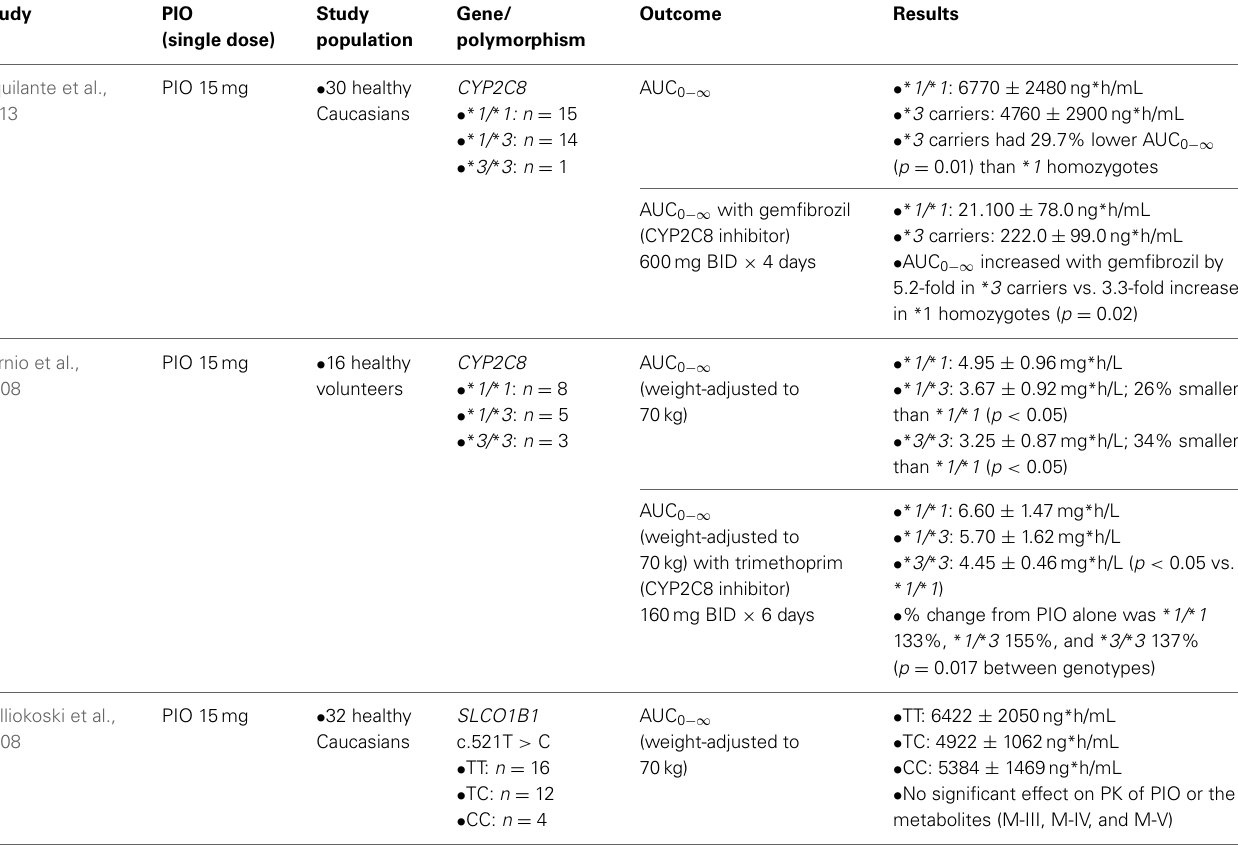
Table 1 | Effect of genetic polymorphisms on pioglitazone pharmacokinetics.